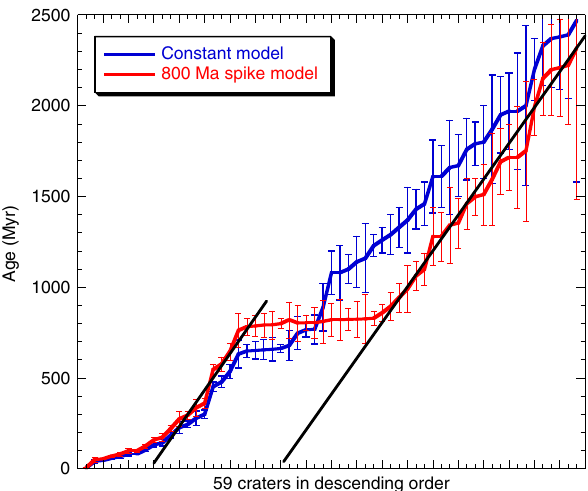
Fig. 6 The 59 crater ages in descending order. The estimated ages of 59 craters based on the constant fl ux model and the 800 Ma spike model are shown in descending order. In both models, it is obvious that the slopes of the lines less than a few million years and ~800Ma are gentler than those of other eras (e.g., 300 – 660 Ma and/or >800 Ma), suggesting the recent increase in impact fl ux forming the large craters ( D > 20